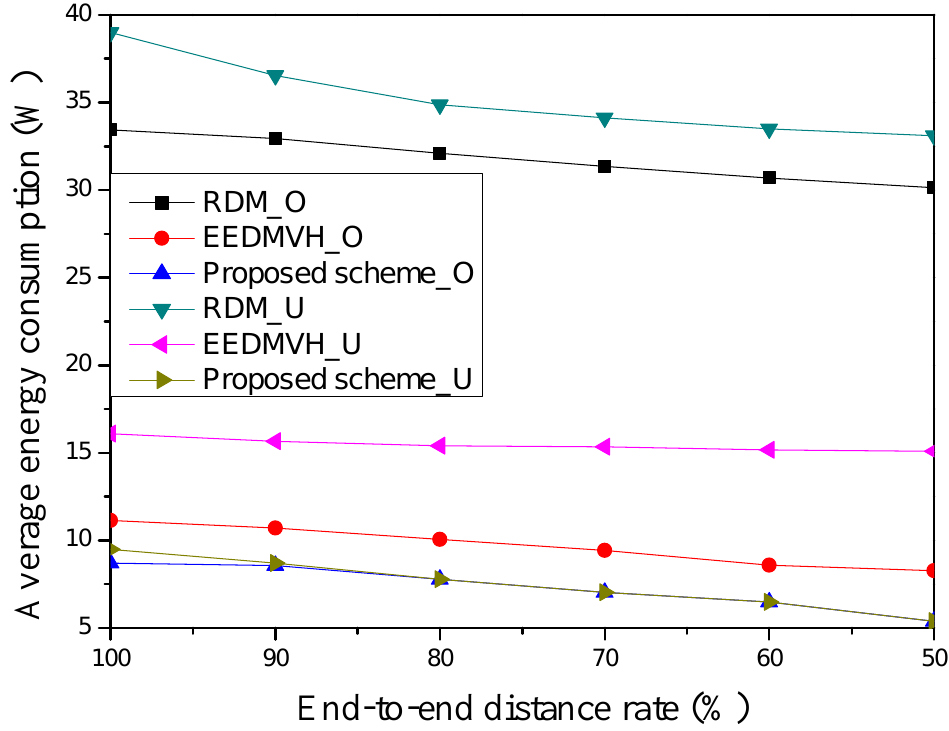
Figure 9. Average energy consumption according to end-to-end